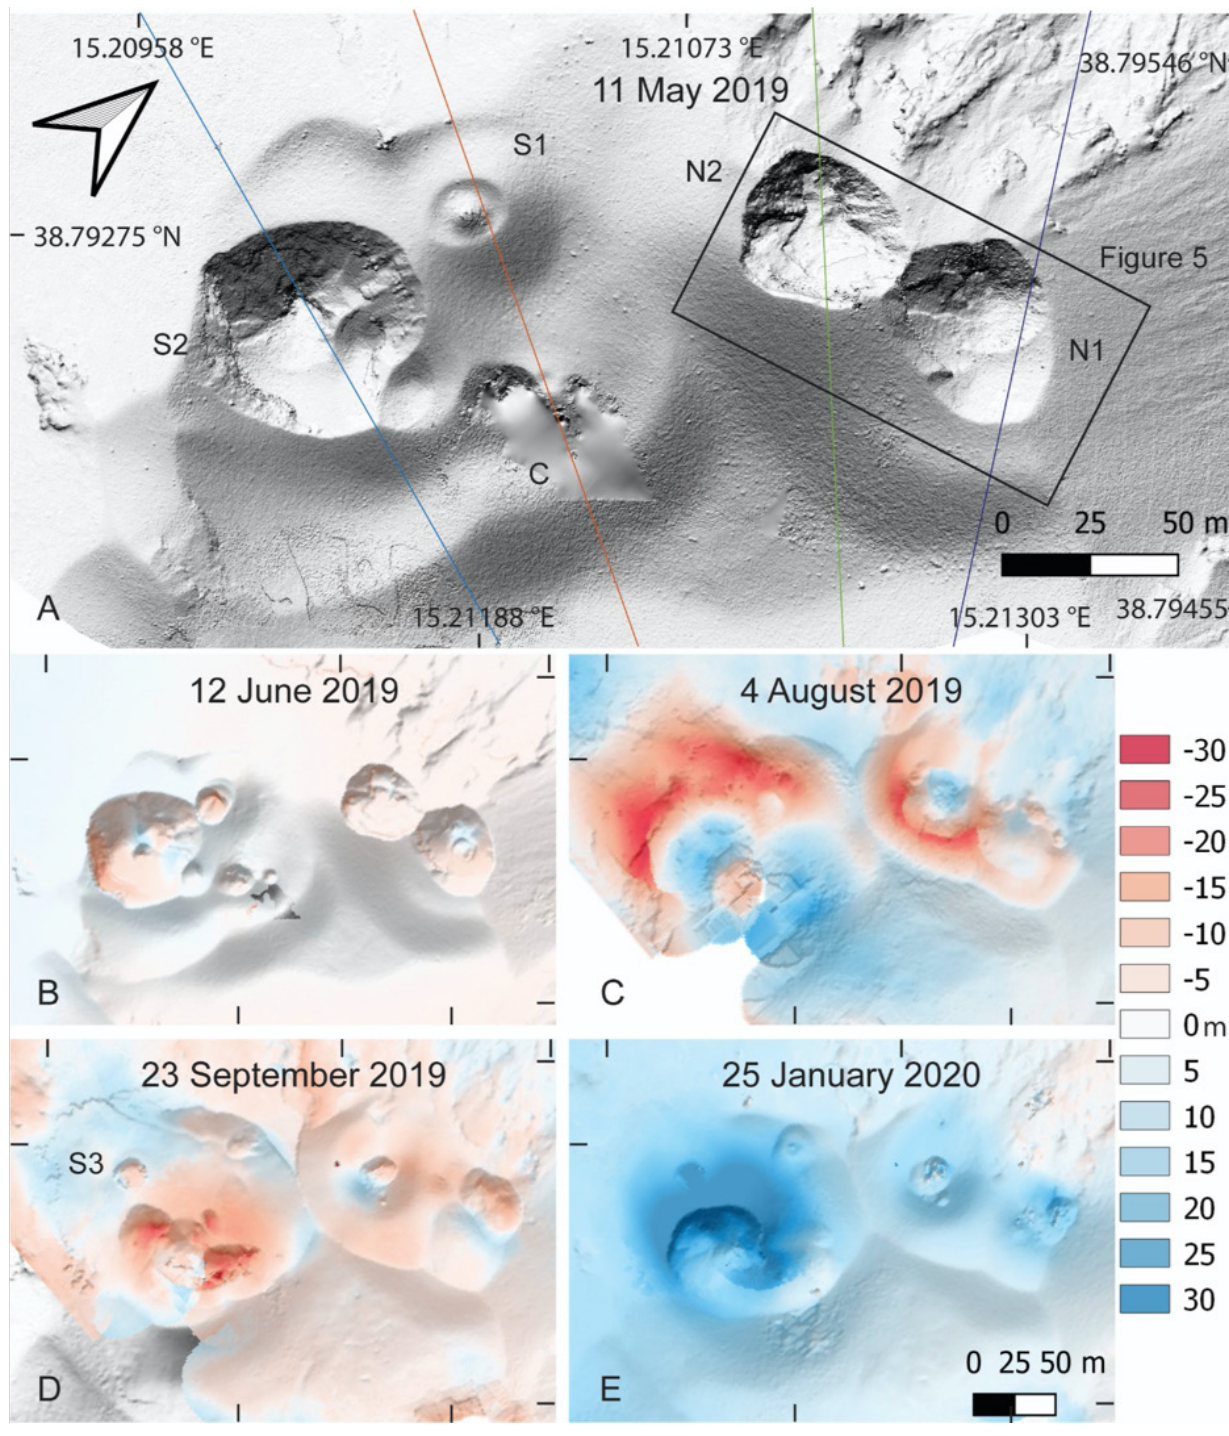
Figure 4: Topographic changes of the summit craters between May 2019 and January 2020 illustrated by DEMs. [A] shows a DEM of 11 May 2019. The coloured lines represent the transects shown in Figure 7 through S2, S1, N2 and N1 (left to right). The DEMs from June to January [B–E] show the topographic changes in relation to the previous one. All DEMs show the same section in the same orientation, arrow indicates North. Each colour of the colour key spans ˘ 2.5 m around the labelled value. Red colour represents negative elevation changes and blue colour positive elevation